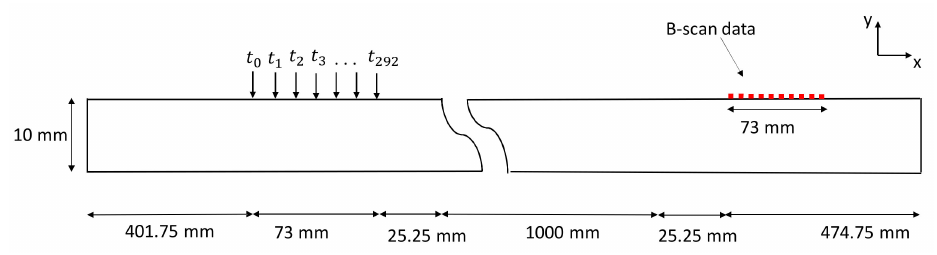
Figure 16. FE model setup for matching with experimental one.